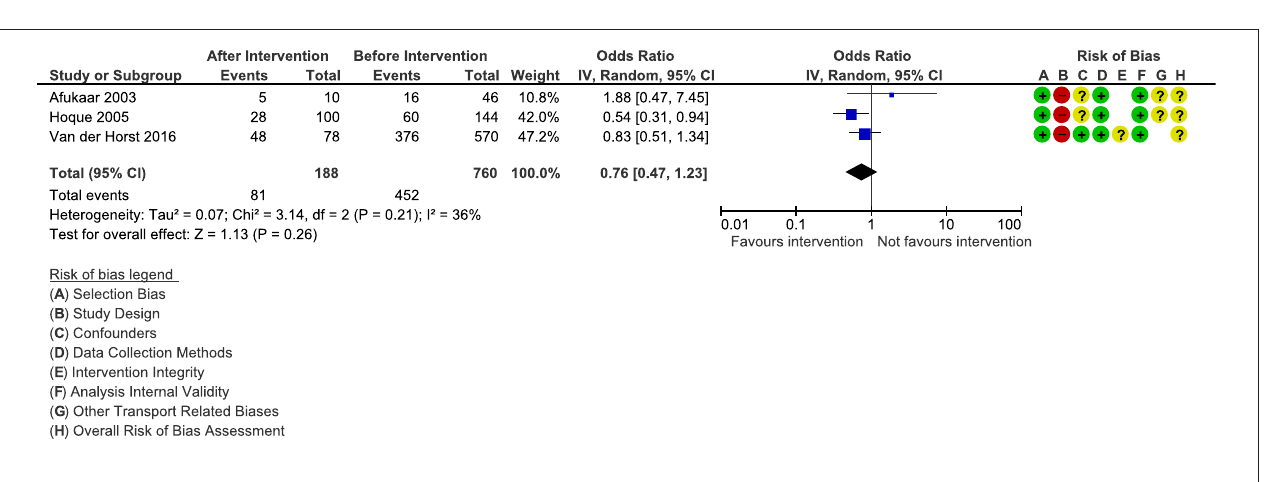
FIGURE 3 | Primary outcome: changes in the number of ‘injuries’ after road engineering interventions.